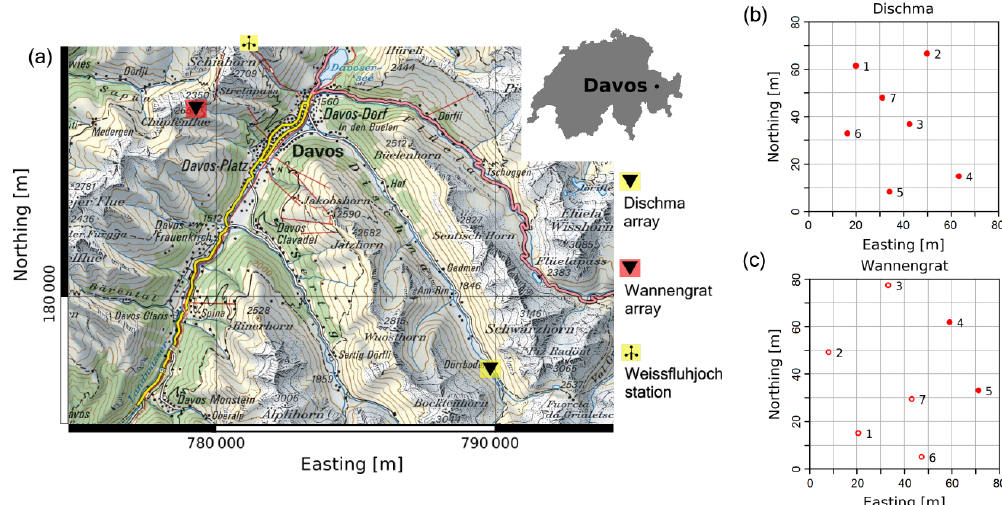
Figure 1. (a) Map of the Davos area, Switzerland. The two seismic arrays are indicated by black triangles on different colored backgrounds: red represents the Wannengrat array, yellow represents the Dischma array. The wind wheel at the top of the panel indicates the location of the Weissfluhjoch weather station. (b) The deployment geometry of the Dischma array. (c) The deployment geometry of the Wannengrat array. The open red circles indicate the positions of malfunctioning sensors during winter 2017. Reproduced with permission from Swisstopo (JA100118).